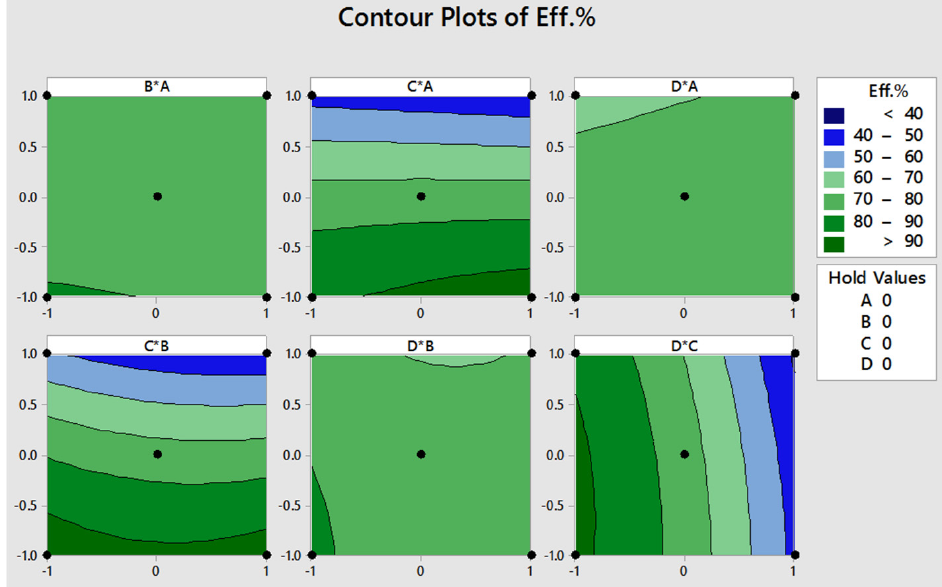
Figure 5. 2D contour plots related to the response surface graph (Figure 4). Each contour plot represents the interaction between two variables moving from the lower level ( − 1) to the upper level (+1) while keeping the other two factors at the middle level (0).